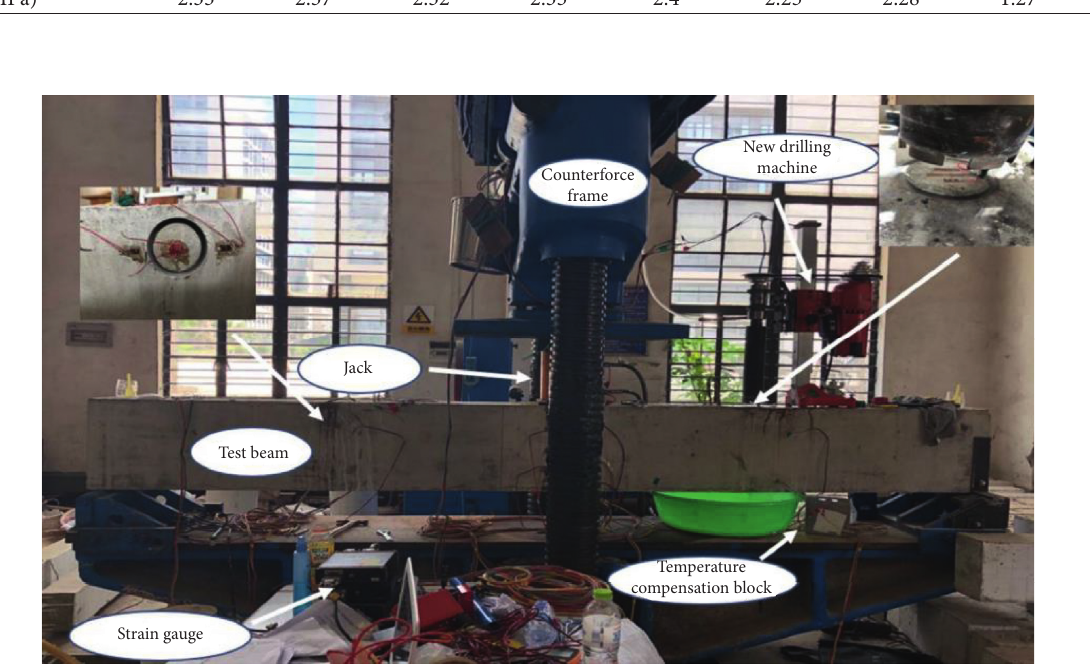
Figure 6: In situ stress test of a beam measured by the CDM.